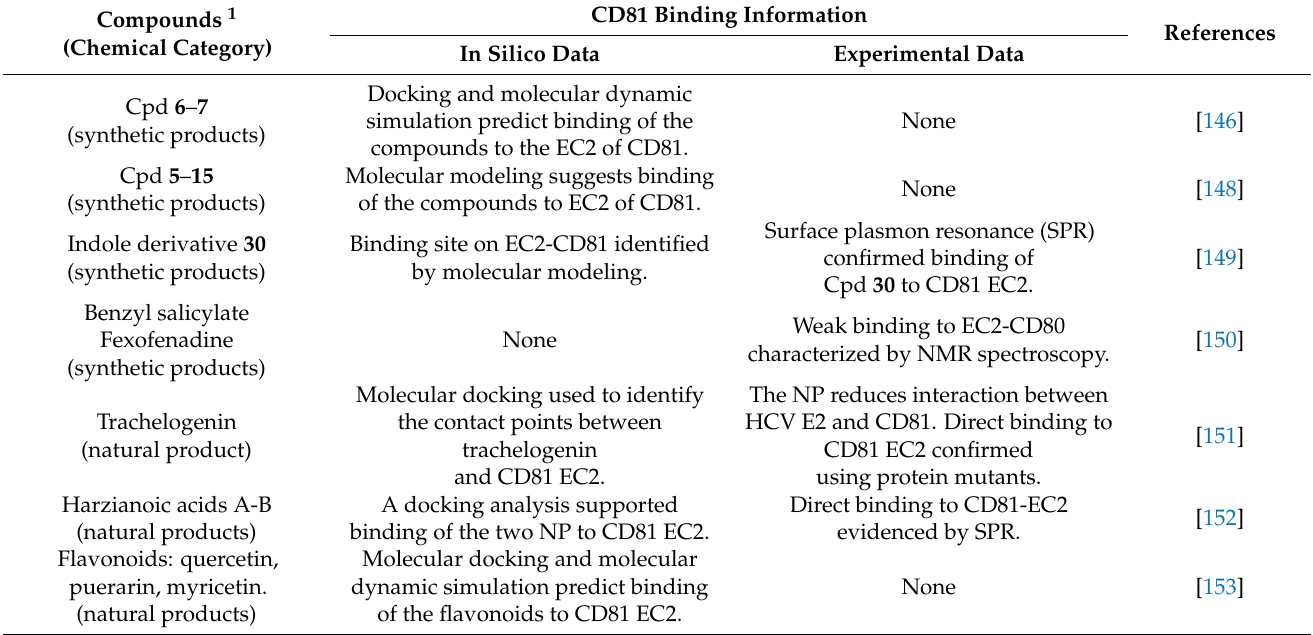
Table 2. Small molecules interacting with